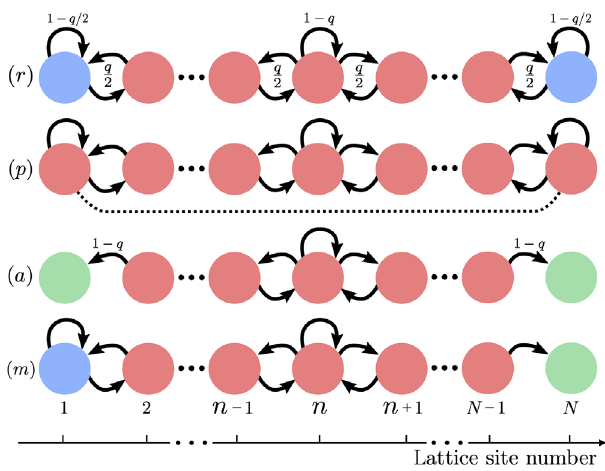
FIG. 1. Pictorial representation of the transition probabilities for a 1D LRW between neighboring lattice sites in the four boundary conditions studied, respectively, ( r ) reflecting, ( p ) periodic, ( a ) absorbing, and ( m ) mixed with one reflecting (left) and one absorbing (right). The boundaries are located at n ¼ 1 and n ¼ N . Any red lattice site represents a lattice in the bulk of the domain for which the probability to move to a nearest- neighbor site is q= 2 ( 0 < q ≤ 1 ) and the probability of staying in place is 1 − q . The boundary lattice sites are colored differently. At a reflecting site (blue circle), the probability of staying is 1 − q= 2 , and q= 2 is the probability of moving towards the inside of the domain. In the translationally invariant periodic case, a dotted line connecting sites n ¼ 1 and n ¼ N to indicate equivalence between site 0 and site N has been drawn. In such a case, all lattice sites are colored red as each one represents a site in the bulk of the domain. At an absorbing lattice point (green circle), only the transition probability 1 − q into the site is possible. For clarity, the transition probabilities have been written only for a subset of the arrows in the